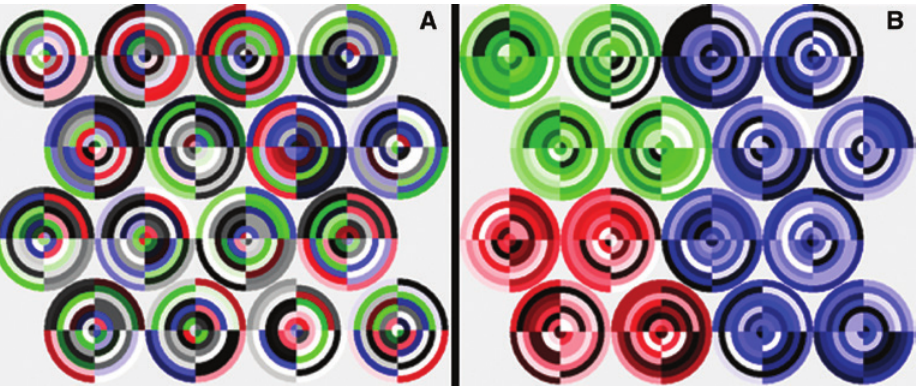
Figure 7: Best Individual from (A) Initial Population and (B) All Generations, for Experiment 9.